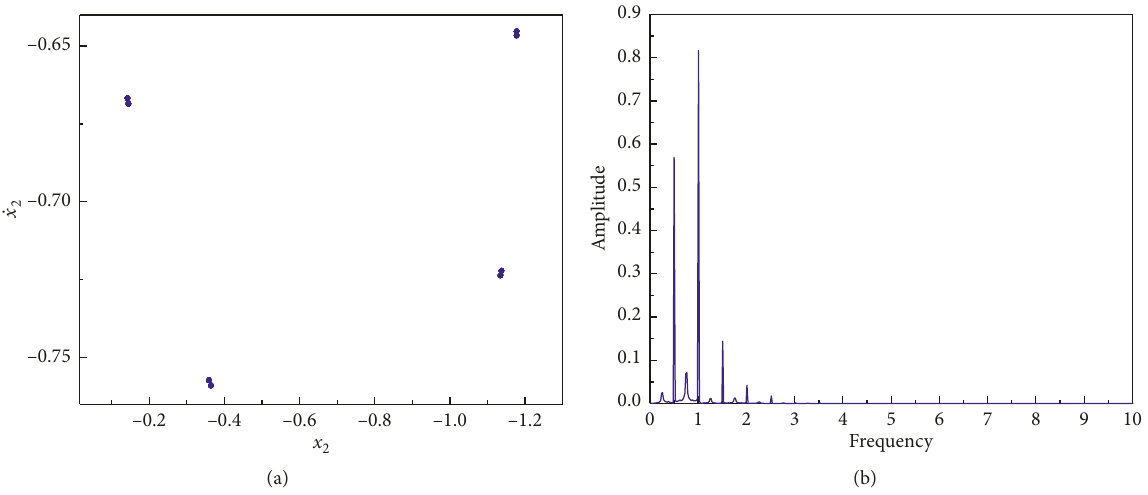
Figure 15: Period-8 motion of the baseplate for Ω � 1 .